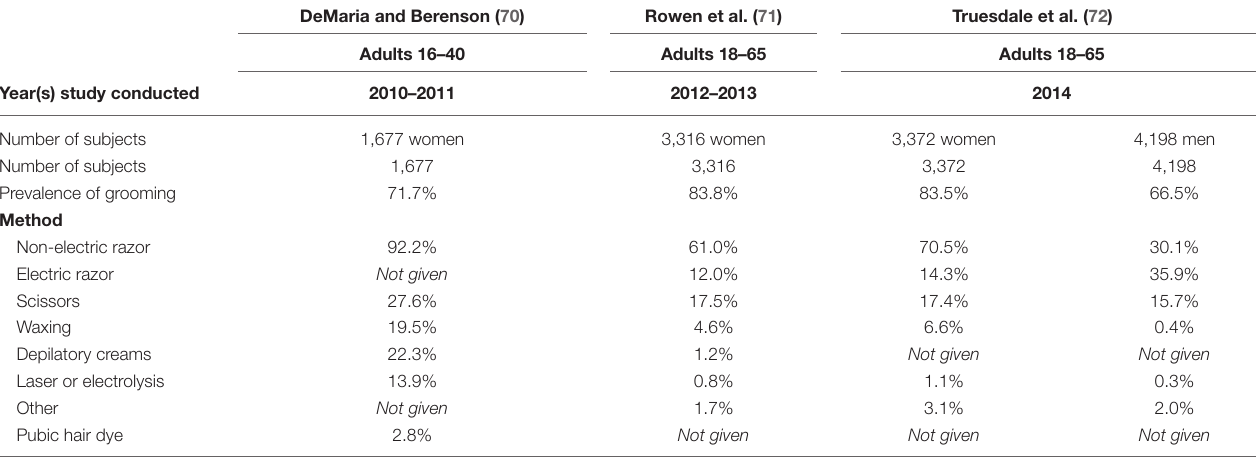
TABLE 5 | Pubic hair grooming